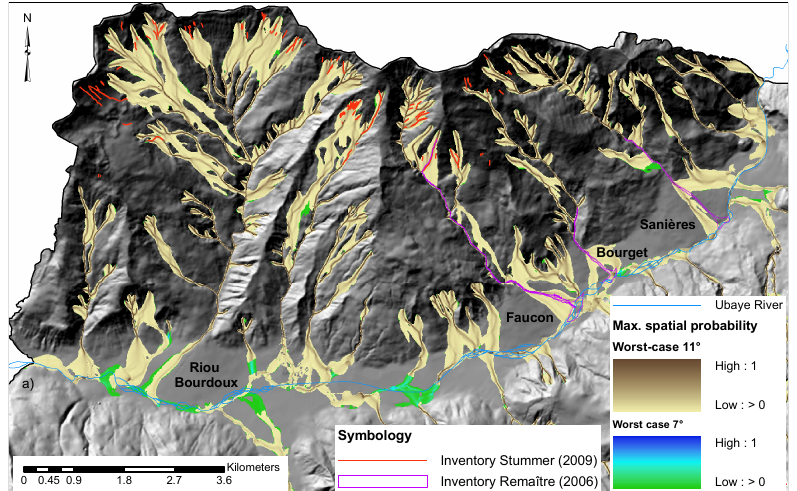
Fig. 6. Worst-case debris-flow scenarios showing the south-facing slope of the Barcelonnette Basin, with angles of reach of 7 ◦ and 11 ◦ (the 7 ◦ scenario is underlying the 11 ◦ scenario and identical with it for the area where it is invisible) in comparison with the debris-flow inventory according to Stummer (2009) and the inventory of Remaˆıtre (2006) which consists of the envelopes of the observed events in 1996, 2002 and 2003.